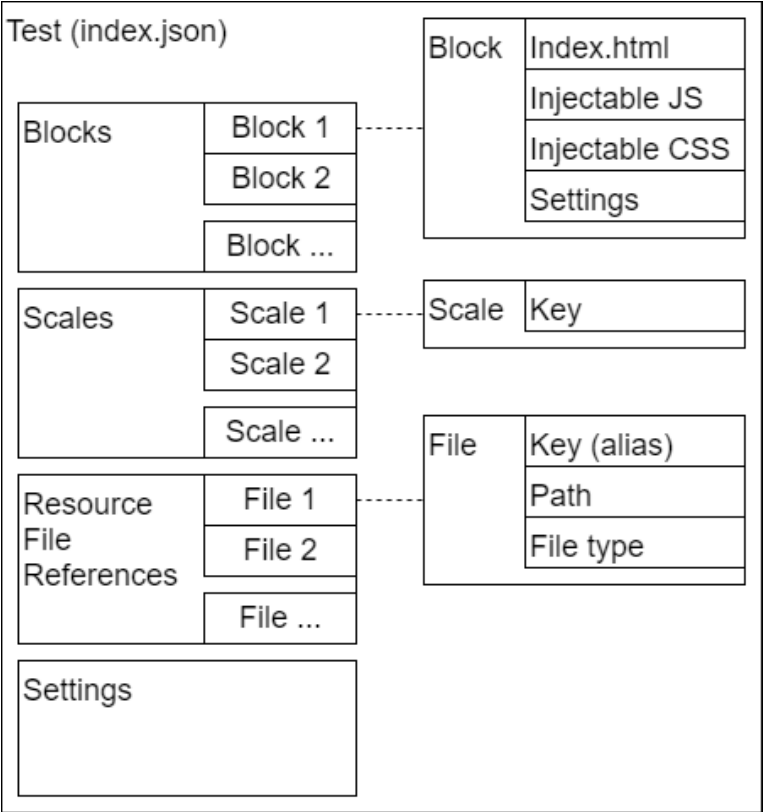
Figure 2. File structure of index.json describing programmable psychological test.